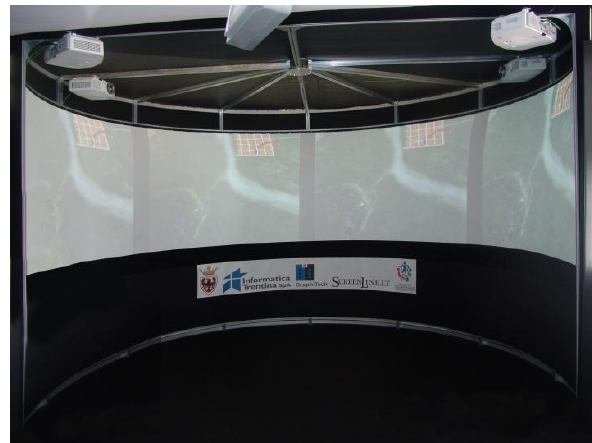
Figure 4: a picture of the tessellated display deployed